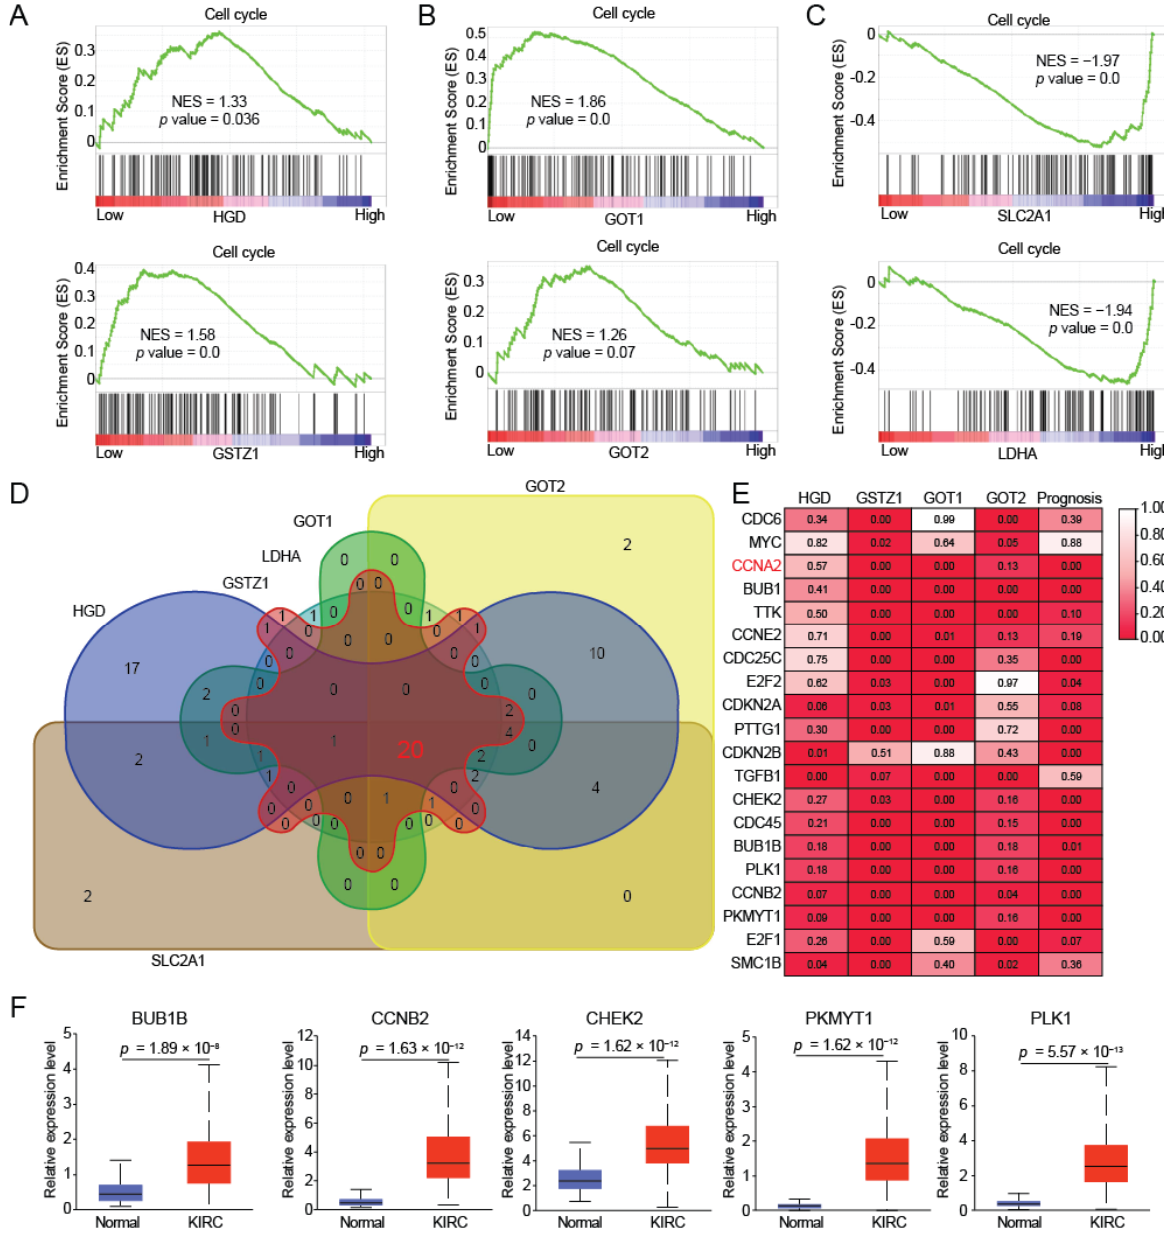
Figure 4. HGD/GSTZ1 promotes cell cycle and tumor progression. ( A – C ) GSEA pathway enrichment analyses of key regulator (HGD, GSTZ1, GOT1, GOT2, SLC2A1, and LDHA) signature in patients with RCC from the TCGA datasets. ( D ) The overlapping analysis for related genes of cell cycle in RCC patients. The number represents the number of genes shared by different gene sets. ( E ) The correlation analysis between HGD/GSTZ1/GOT1/GOT2/prognosis and cell cycle related target genes. ( F ) The cell cycle related key target genes mRNA expression levels between tumor and normal tissues in patients with KIRC in TGCA database.